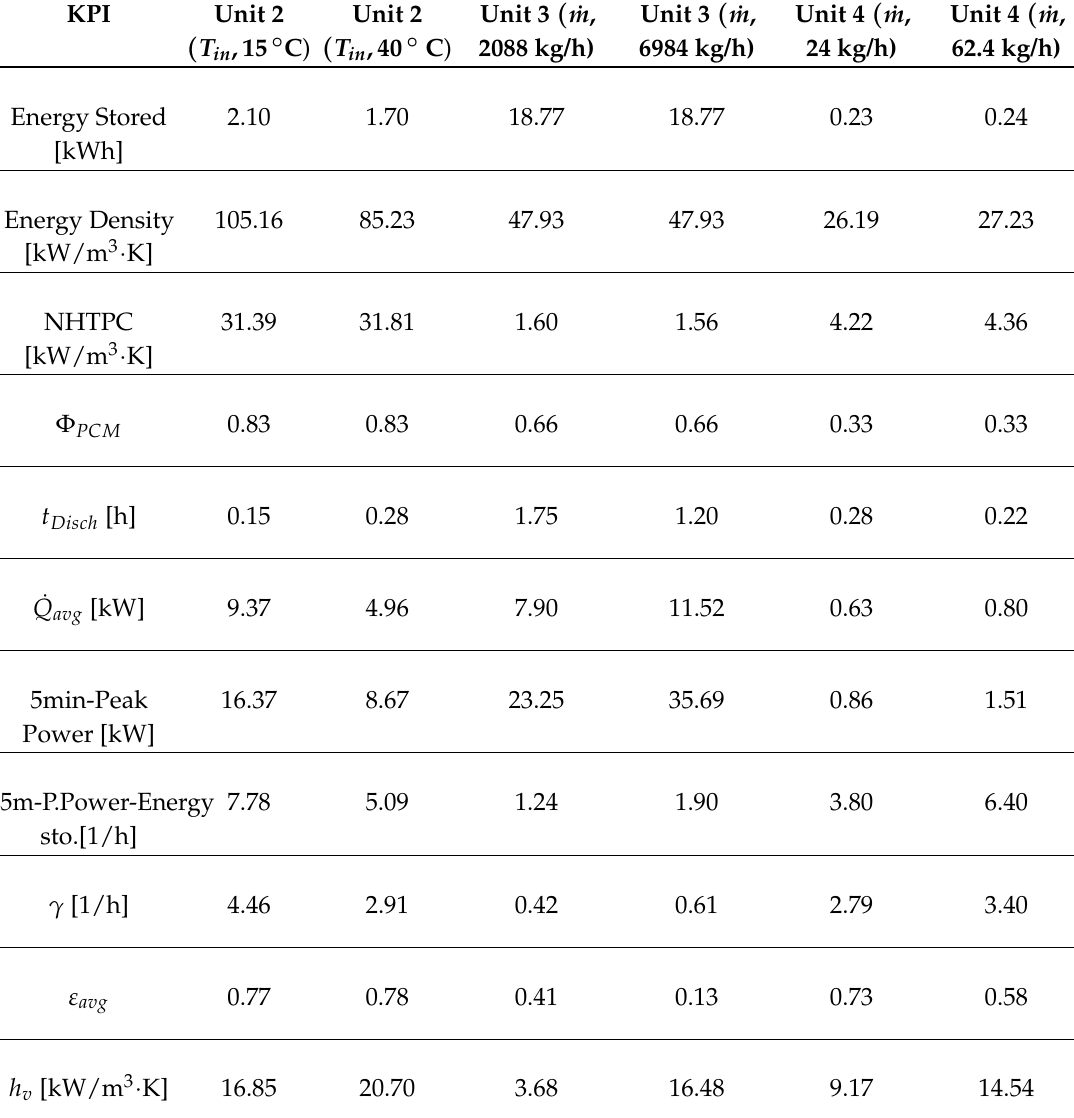
Table 5. Comparison of different KPIs for